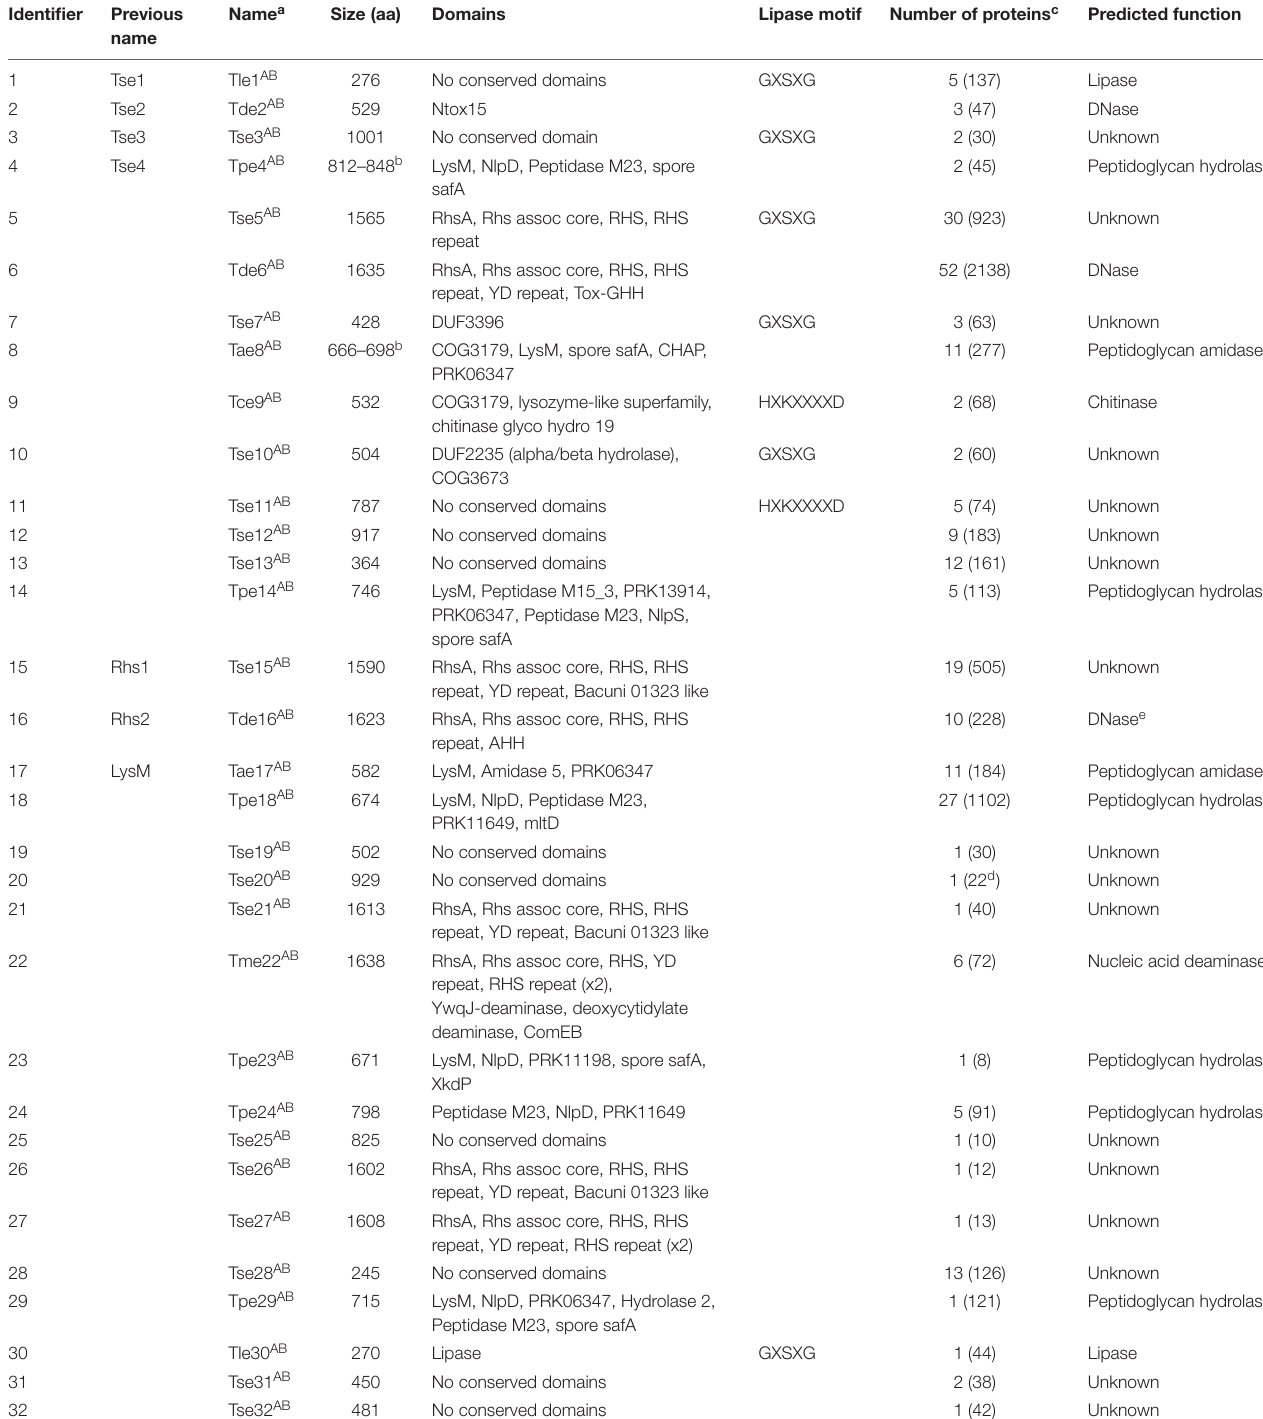
TABLE 1 | Putative A. baumannii T6SS effector protein